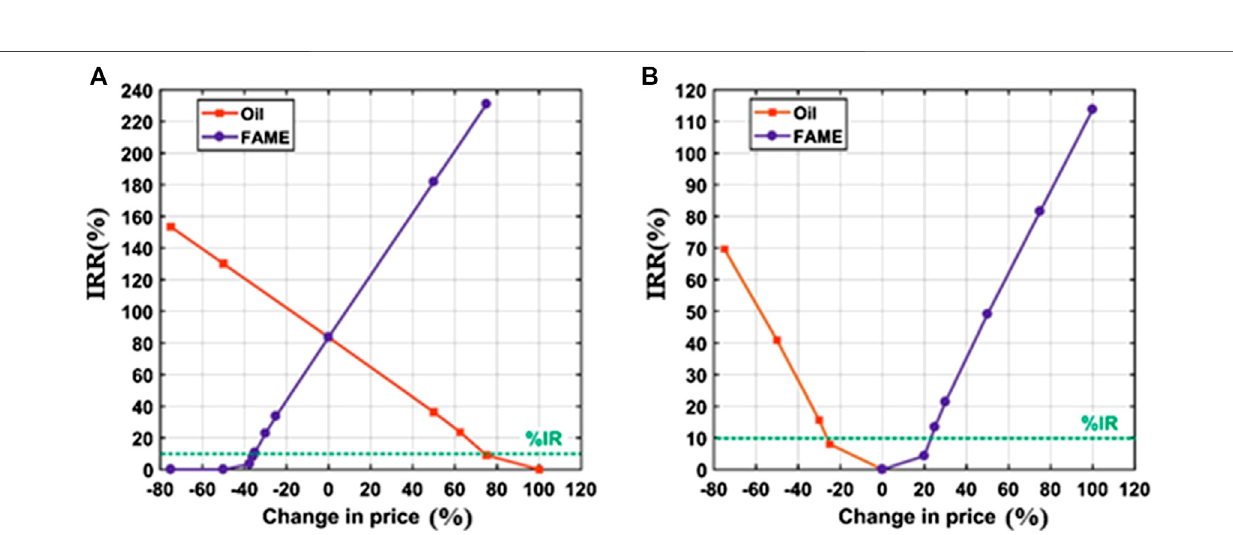
Frontiers in Energy Research |